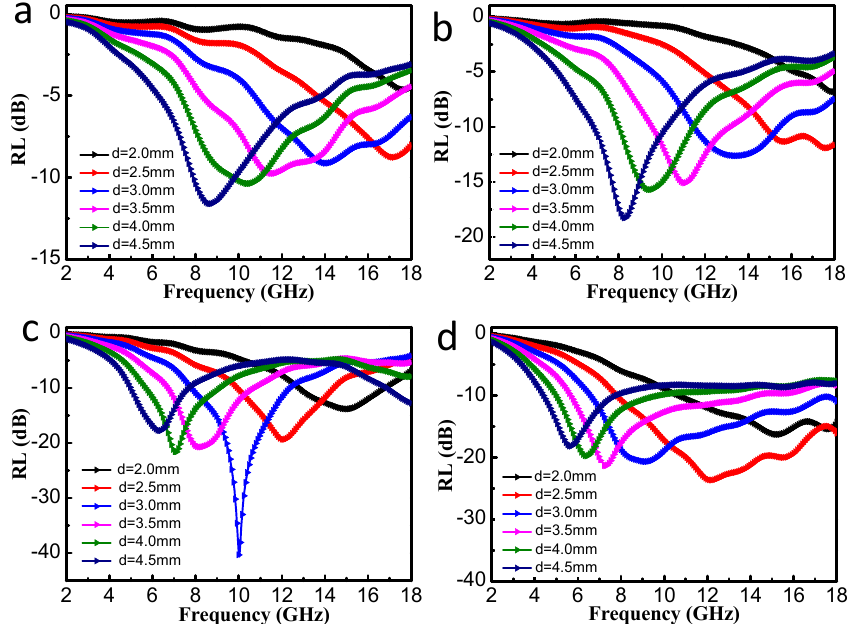
Figure 6. Calculated reflection loss (RL) curves of the S2–paraffin composites with different absorber thicknesses: ( a ) S2–10 wt%, ( b ) S2–20 wt%, ( c ) S2–30 wt%, and ( d ) S2–40 wt%.